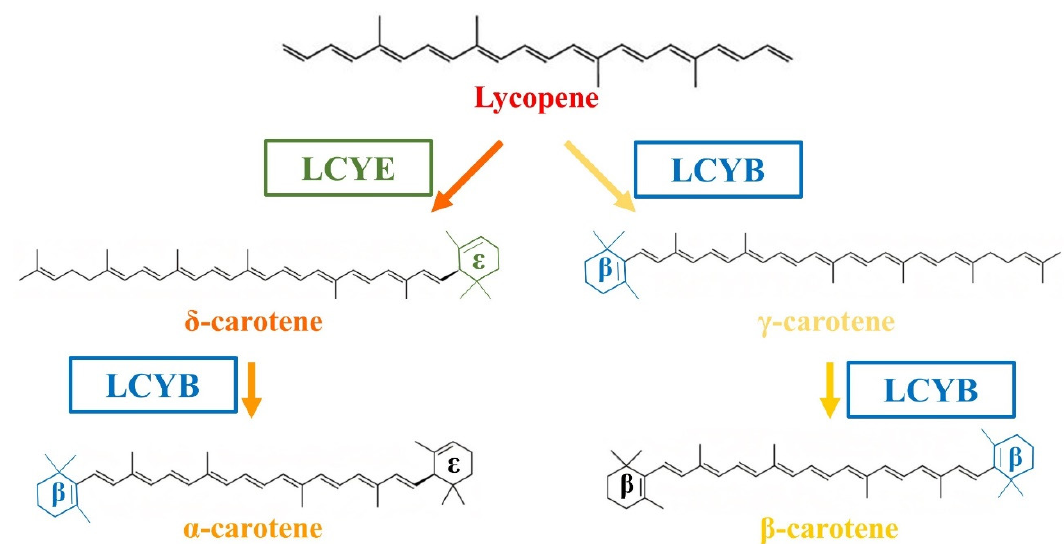
Figure 1. Biosynthesis pathway for α -carotene and β -carotene. Red arrows represent the α -carotene- forming branch, while black arrows represent competing branch leading to β -carotene. Enzymatic conversions were shown by arrows with related enzymes involved in each reaction. The conversion of lycopene to β -carotene requires only lycopene β cyclase. The conversion of lycopene to α -carotene requires both lycopene β and ε cyclases.